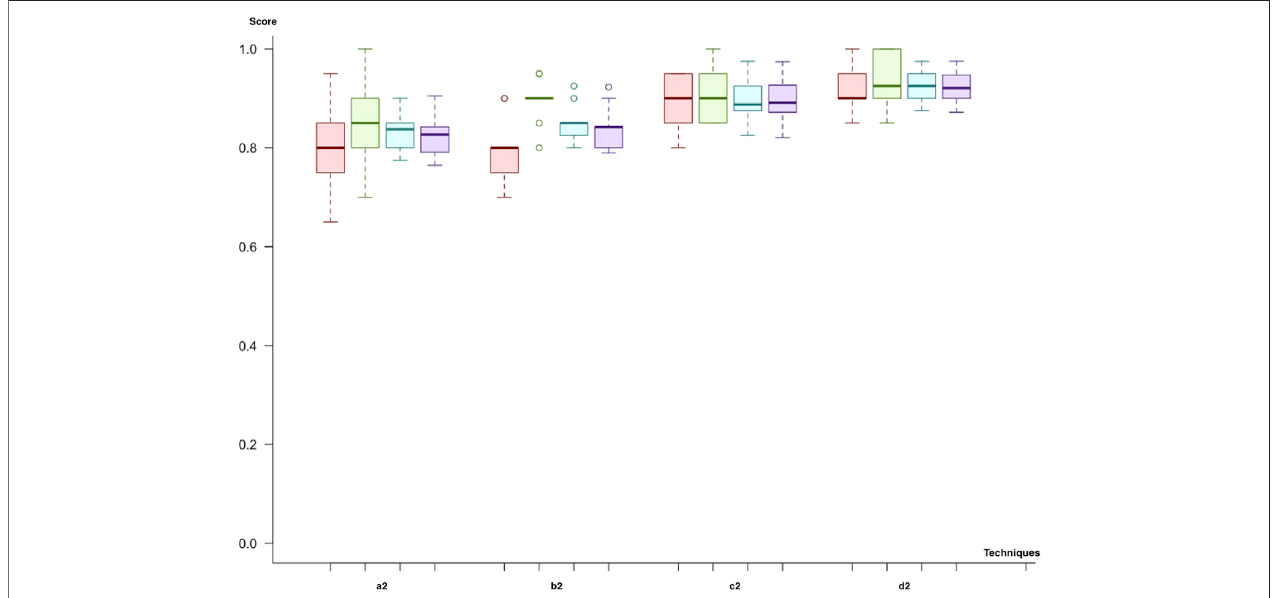
FIGURE 7 | Model comparison of techniques used for miRNA and mRNA biomarkers (red, sensitivity; green, predictivity; blue, accuracy; purple, F-score): the model listed in 4, which applies (d2), is selected as the successor model for the second cycle.